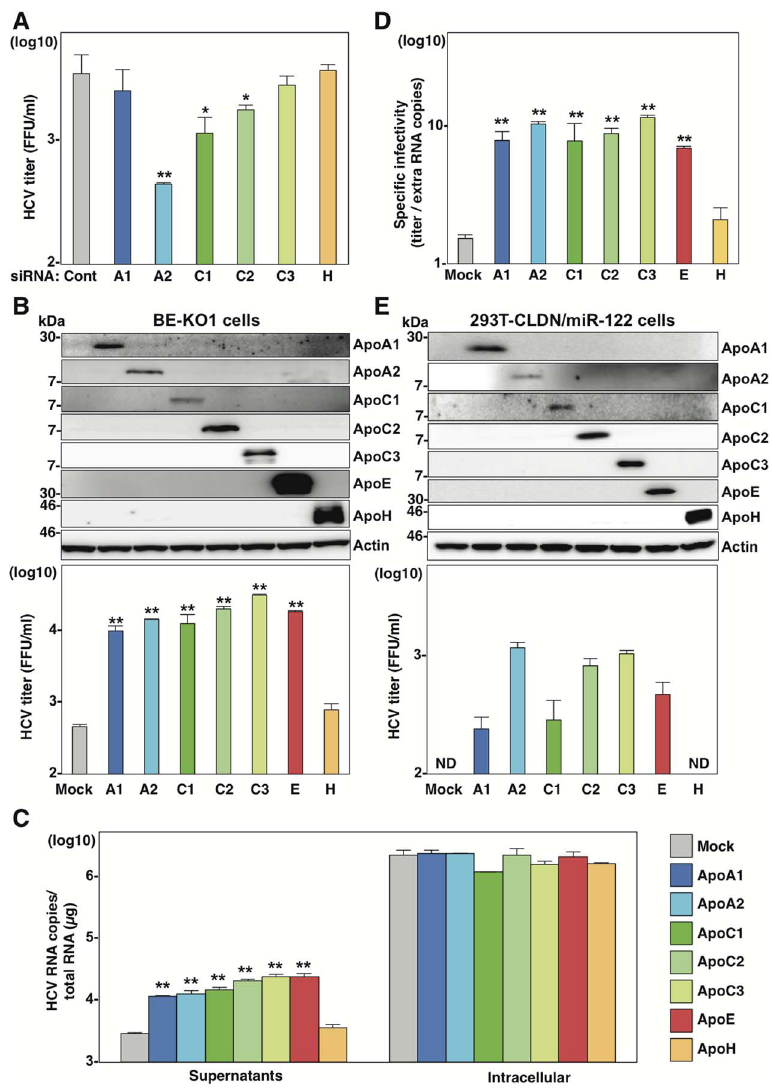
Figure 4. Exchangeable apolipoproteins redundantly participate in the formation of infectious HCV particles. (A) BE-KO1 cells infected with HCVcc at an MOI of 1 at 6 h post-transfection with siRNAs targeting ApoA1 (A1), ApoA2 (A2), ApoC1 (C1), ApoC2 (C2), ApoC3 (C3) and ApoH (H) and infectious titers in the culture supernatants were determined by focus-forming assay at 72 h post-infection. (B) ApoA1, ApoA2, ApoC1, ApoC2, ApoC3, ApoE and ApoH were exogenously expressed in BE-KO1 cells by infection with lentiviral vectors, and then infected with HCVcc at an MOI of 1. Expression of the apolipoproteins was determined by immunoblot analysis (upper), and infectious titers in the culture supernatants were determined at 72 h post-infection by focus-forming assay (lower). (C) Extracellular and intracellular HCV RNA in BE-KO1 cells expressing apolipoproteins and infected with HCVcc were determined at 72 h post-infection by qRT-PCR. (D) Specific infectivity was calculated as extracellular infectious titers/ extracellular HCV RNA copies in BE-KO1 cells expressing apolipoproteins at 72 h post-infection. (E) 293T cells stably expressing CLDN1 and miR-122 (293T-CLDN/miR-122 cells) were infected with the lentiviral vectors, and the expressions of the apolipoproteins were determined by immunoblot analysis (upper). These cells were infected with HCVcc at an MOI of 1, and infectious titers in the supernatants were determined at 72 h post-infection by focus-forming assay (lower). In all cases, asterisks indicate significant differences (*, P , 0.05; **, P , 0.01) versus the results for control cells.